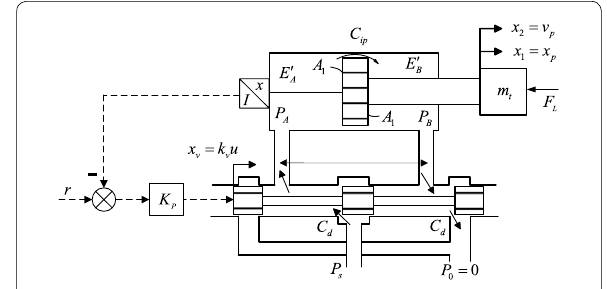
Figure 3 Principle of the hydraulic servo